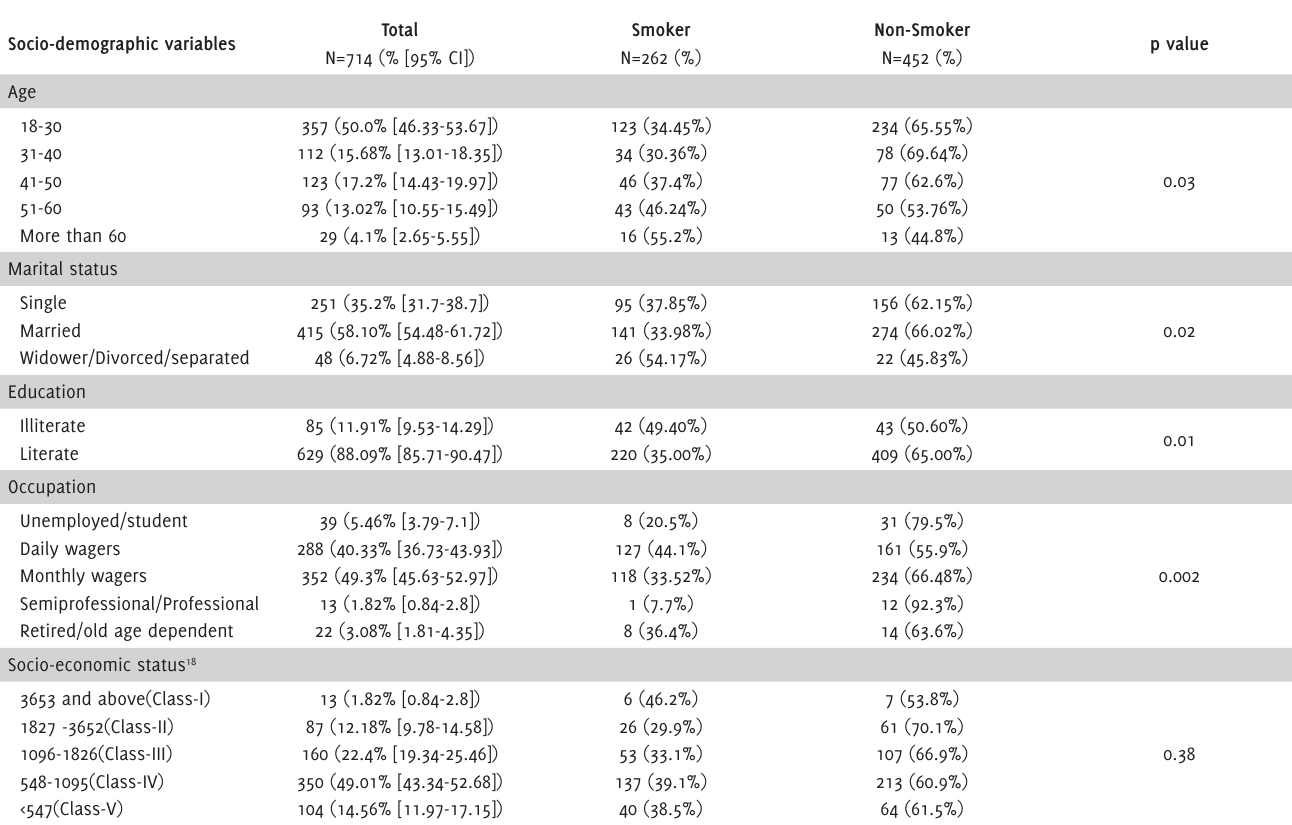
Table 1: Socio-demographic determinants of tobacco use